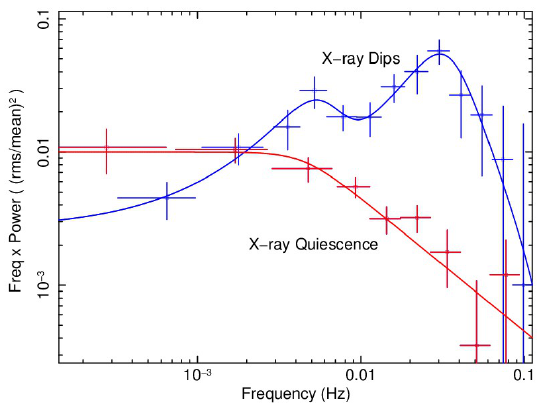
Figure 2: The RXTE PDS of SS Cyg in quiescence and during the optical peak of outburst (top). The solid lines show the fit with the propagating fluctua- tions model along with two